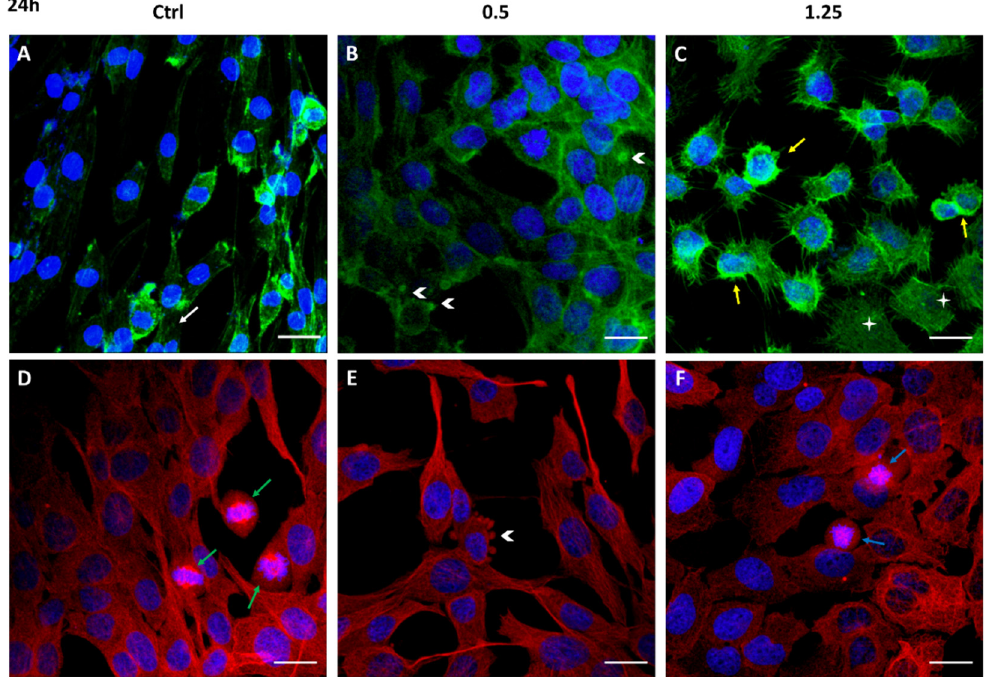
Figure 4. Cytoskeleton structure analysis of 1321N1 cells untreated ( A , D ) and treated with 0.5% ( B , F ) and 1.25% v / v ( C , D ) Rapha Myr ® extract for 24 h. Representative IF images for actin stained with FITC-Phalloidin (green; A , B , C ), microtubules stained with anti– α -tubulin antibody (red; D , E , F ) and nuclei stained with DAPI (blue), a merge was made. White arrows: stress fibers; yellow arrows: cellular cortex; arrowheads: blebs; green arrows: mitosis; blue arrows: abnormal mitosis. Scale Bar: 20 µm.